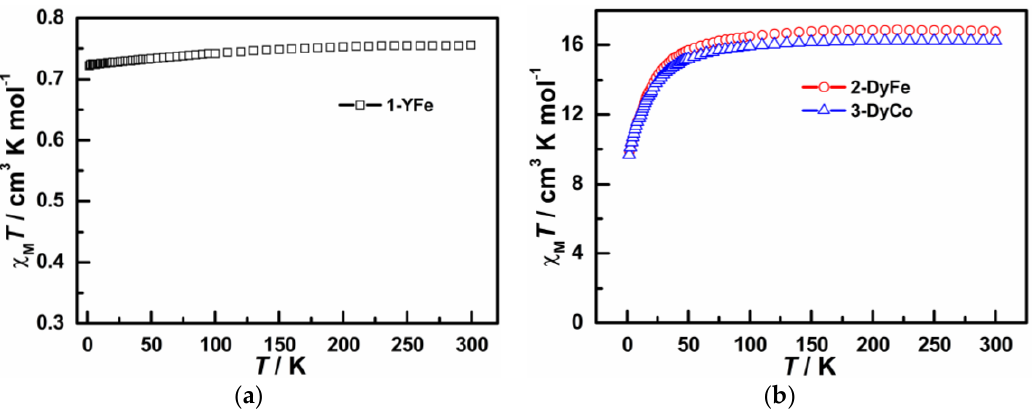
Figure 2. Temperature dependence of the χ M T products at 1 kOe dc field for compounds ( a ) 1 ; ( b ) 2 and 3 .